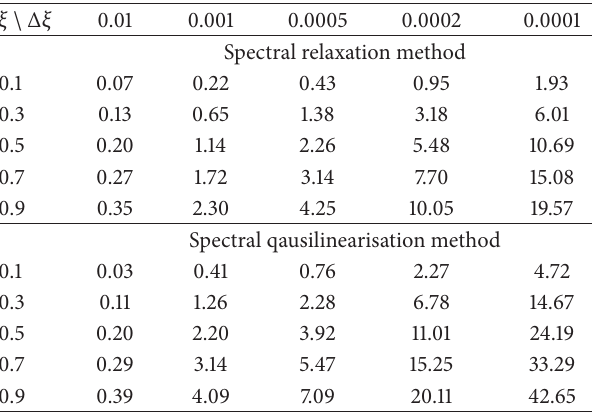
Table 3: SRM and SQLM computational times for Example 1. Table 4: Comparison between the SRM and Keller-Box